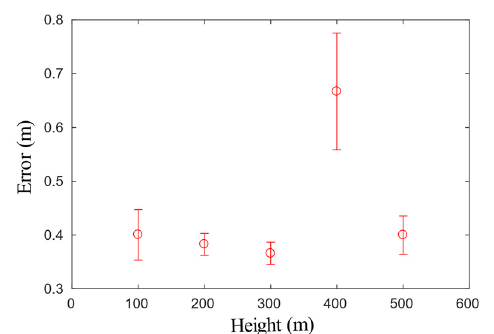
Figure 5. The bar diagram of positioning error. Table 2. The aircraft positioning error.